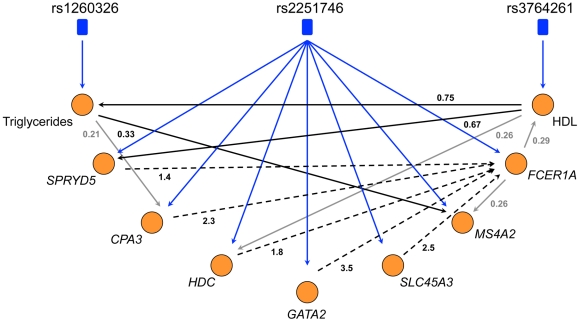
The directed network of core LL module, HDL, and triglycerides.NEO was used to generate an edge-oriented network of triglycerides, HDL, and core LL module genes. Blue edges denote significant correlations between SNPs and nodes (orange circles), black edges denote significant correlations between nodes with a corresponding LEO score greater than 0.3 (predicted as a causal edge) while grey edges denote significant correlations between nodes with a LEO score less than 0.3 (causality is inconclusive). Dotted edges signify causal model fitted P values <0.05.